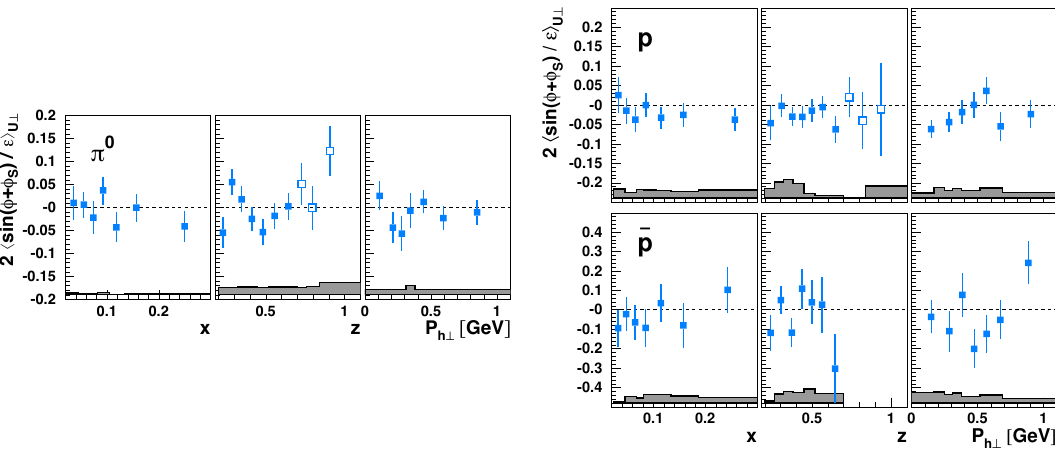
Figure 11 . Collins SFA for π 0 (left), protons, and antiprotons (right) presented either in bins of x , z , or P h ⊥ . Data at large values of z , marked by open points in the z projection, are not included in the other projections (no such high- z points are available for antiprotons due to a lack of precision). Systematic uncertainties are given as bands, not including the additional scale uncertainty of 7.3% due to the precision of the target-polarization